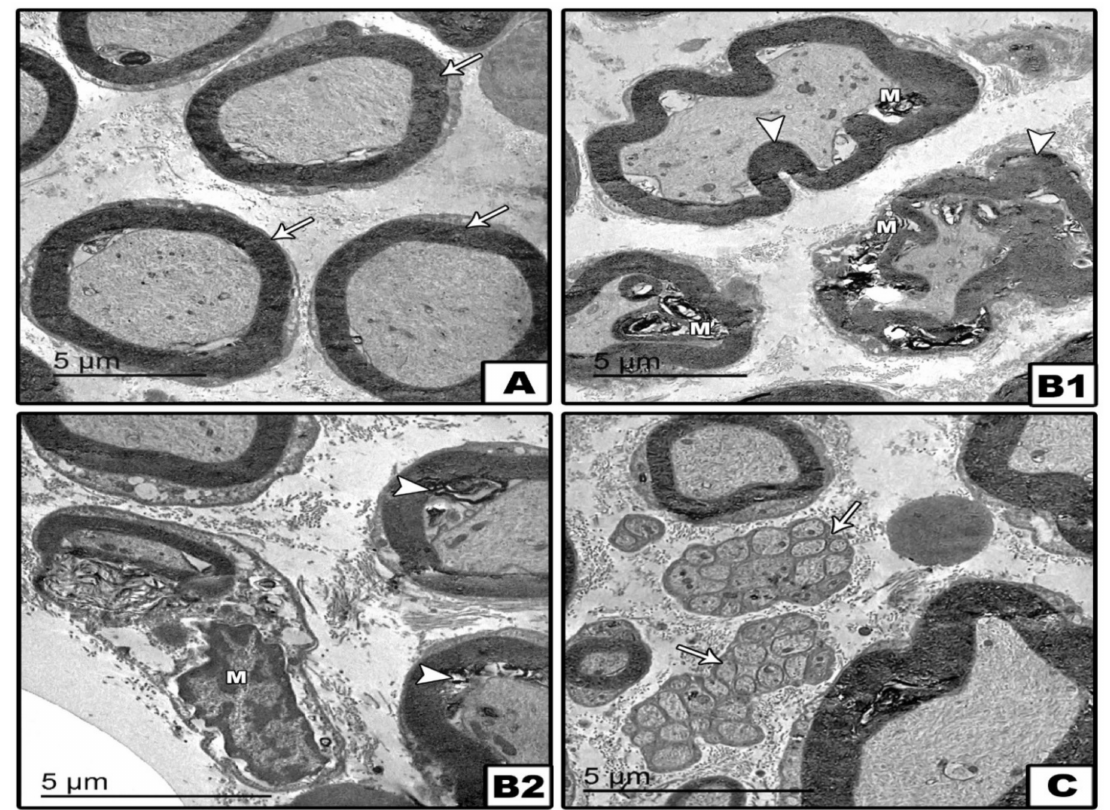
Figure 9. Transmission electron microscopy images of sections of the spinal cord. Images in groups; control, diabetic, and treated diabetic group. Panel ( A ): control section showing the normal characteristics of myelinated axons with regular myelin sheathes (arrows). Panel ( B1 , B2 ) diabetic sections showing degenerated myelinated axons (head arrows) and phagocytic microglia/macrophage cells (M) with degenerating myelin and phagocytosed matter in the cytoplasm in the white matter. The degenerated axons showing disorganized myelin sheathes with swollen vacuolated axoplasm. Microglia are surrounding the degenerated axon of a collapsed myelin sheath. Panel ( C ) Treated group showing myelinated axons with regular myelin sheathes, and very small unmyelinated axons were found with thickened Schwan cell basement membranes